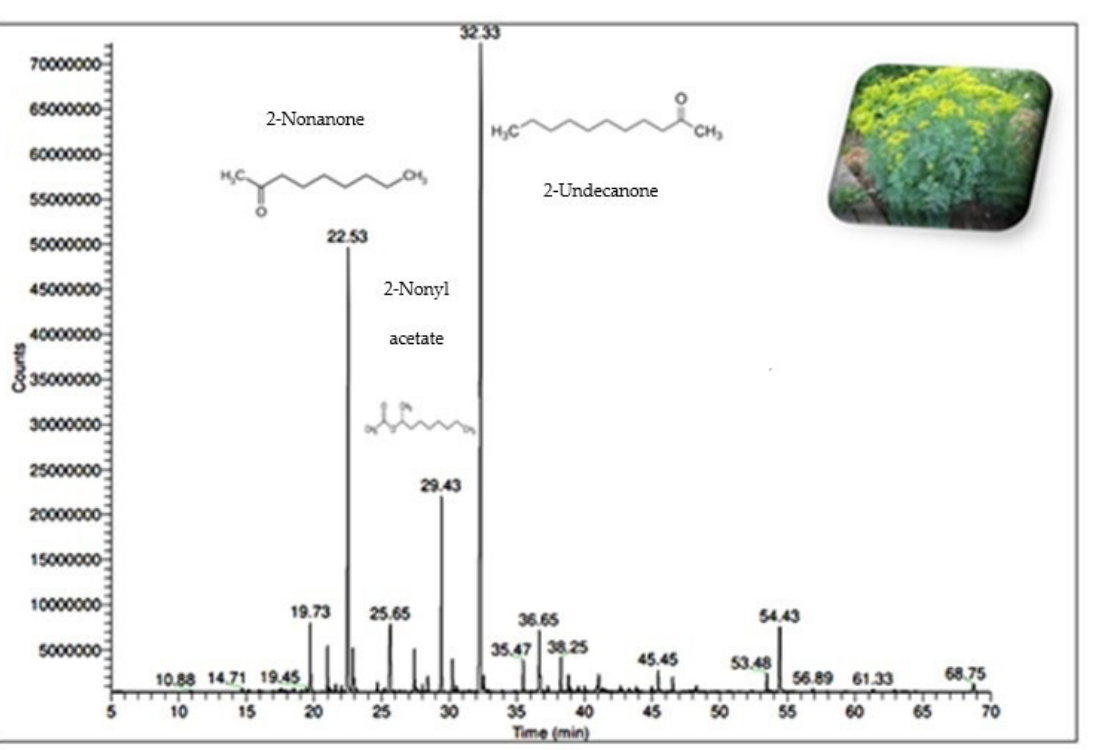
Table 2. Results of the antioxidant activity test for Ruta chalepensis oil using DPPH, nitric oxide scavenging, and reducing power (FRAP) assays.